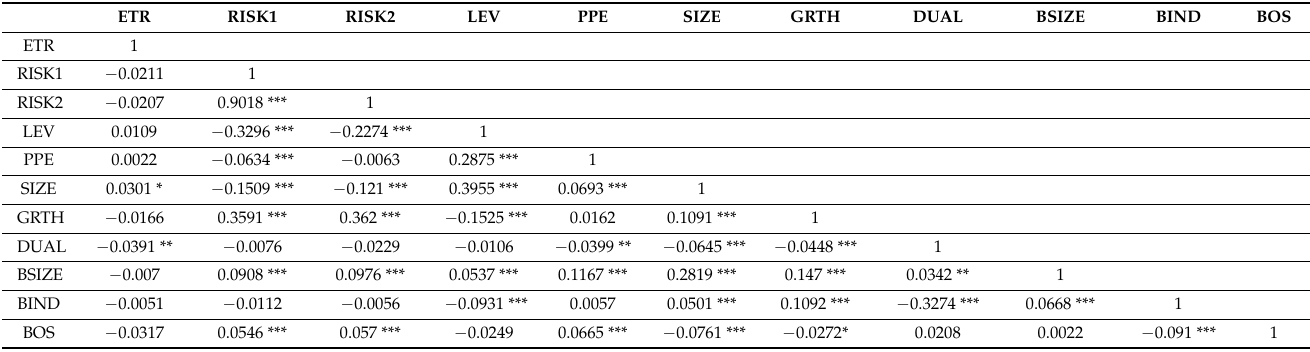
Table 5. Correlation matrix of